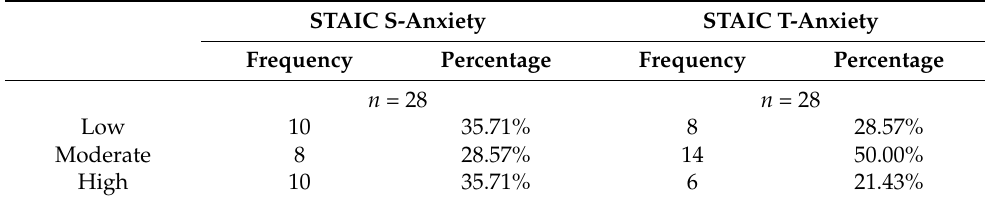
Table 3. Distribution of STAIC S-Anxiety and STAIC T-Anxiety levels. STAIC S-Anxiety STAIC T-Anxiety Frequency Percentage Frequency Percentage n = 28 n = 28 Low 10 35.71% 8 28.57% Moderate 8 28.57% 14 50.00% High 10 35.71% 6